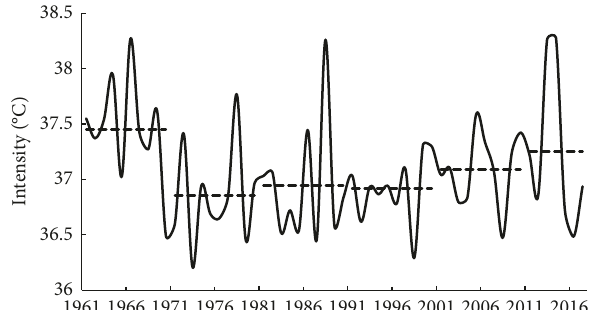
Figure 3: Intensity of heatwave events on the North China Plain.